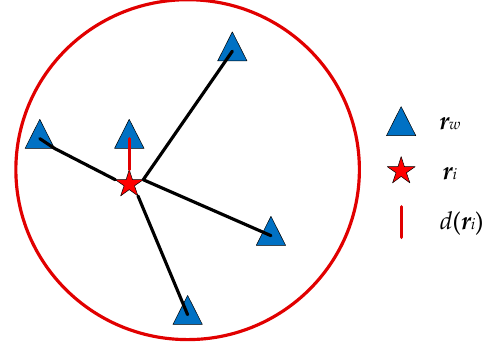
Figure 4. The diagram of effective distance.